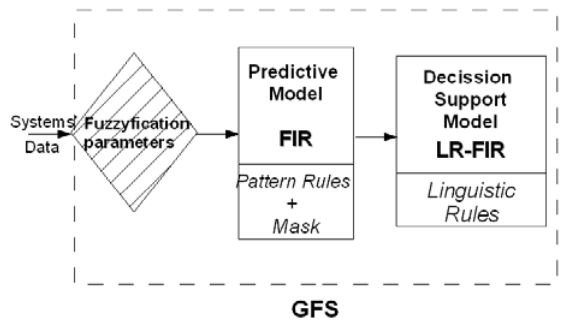
Fig. 5. Scheme of the